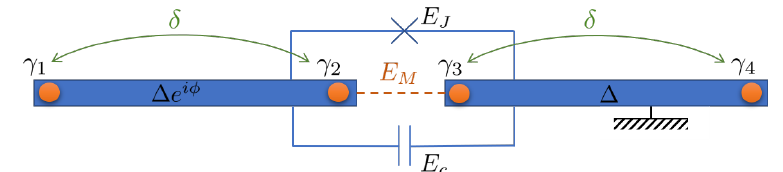
Figure 2: Minimal model describing a nanowire in the topological phase, with Majo- rana zero modes, γ , at the ends of the topological superconducting i = 1,..,4